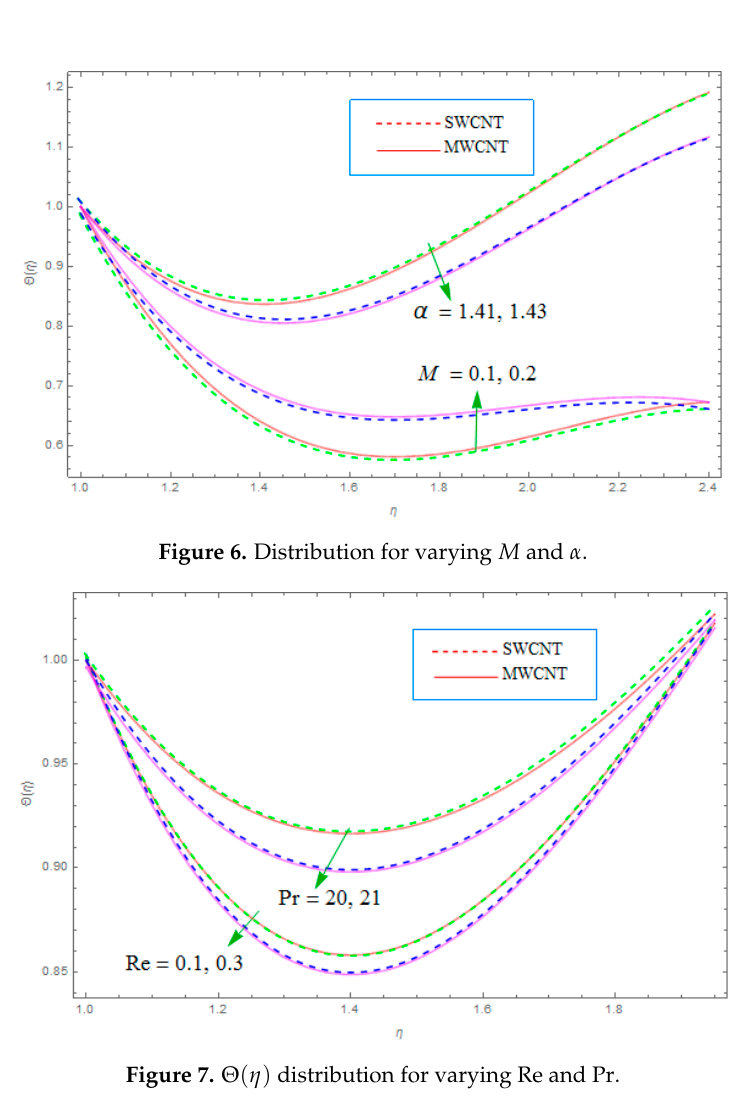
Figure 7. Θ ( η ) distribution for varying Re and Pr .